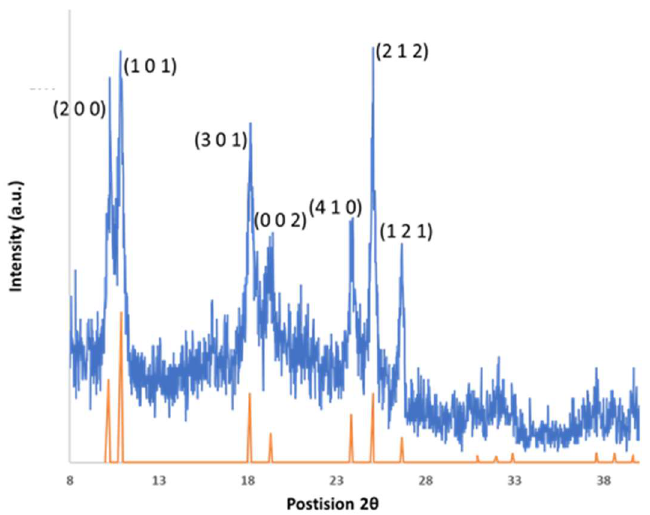
Figure 4. Observed XRD pattern for [Fe(Htrz) 2 (trz)](BF 4 )] (top, blue) versus the simulated low spin reference pattern (bottom, orange). Broad diffraction peaks are observed, consistent with the nanoparticle nature of the sample. Reference pattern calculated from published data [14].